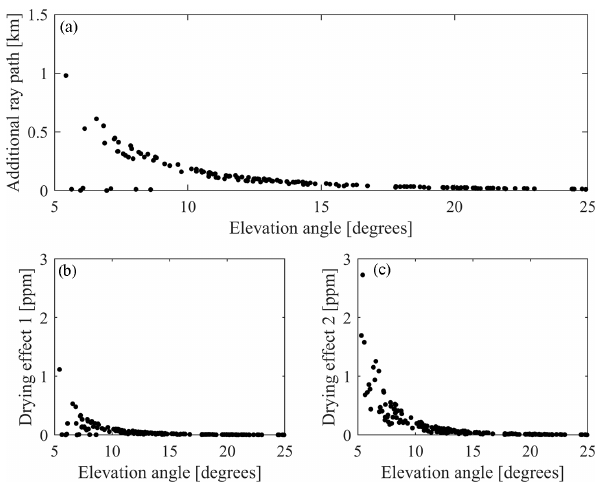
Figure 6. Additional ray path caused by the straight-line assump- tion (a) , the resulting drying effect due to the additional ray path (b) and the resulting drying effect caused by the fact that the straight- line ray travels through lower atmospheric levels than the true bended ray (c)